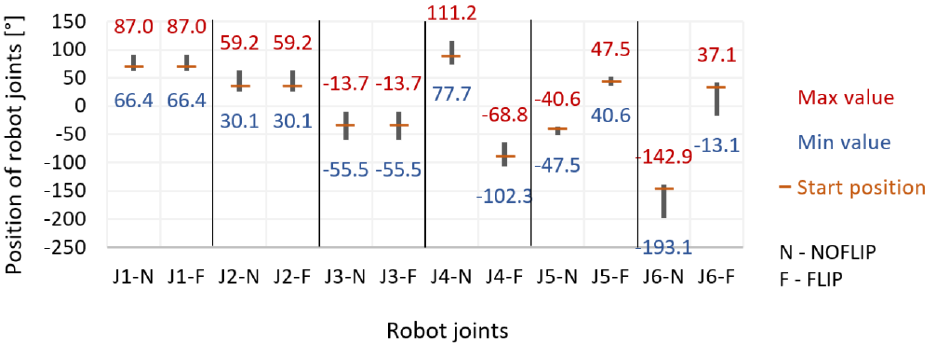
Figure 11. Comparison of the movement of robot joints for both used robot arm configurations.